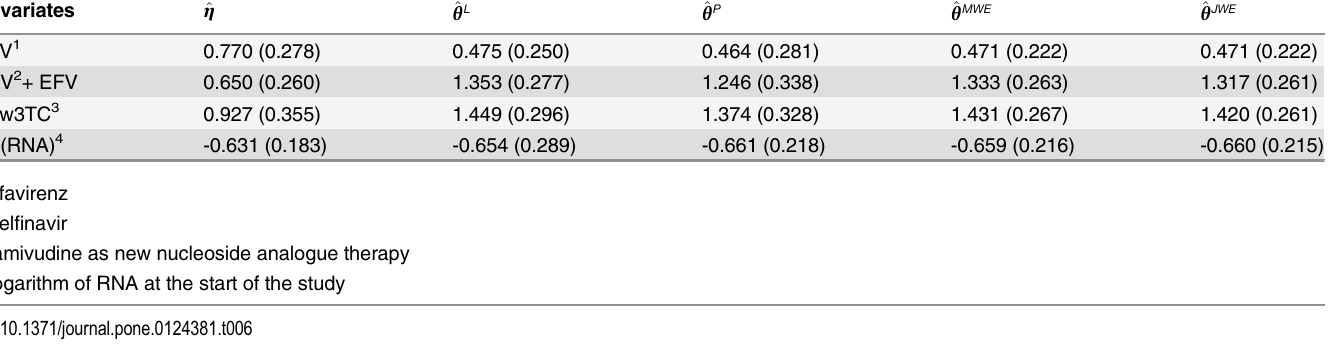
Table 6. Point estimates with standard errors of covariates in AIDS study for model with New3TC (Standard errors are shown in parenthesis).